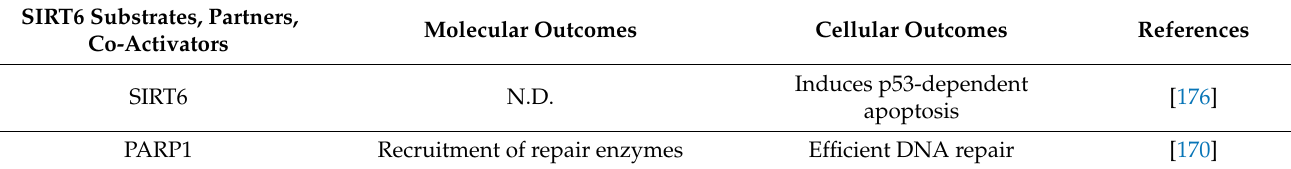
Table 3. Substrates and biological roles of